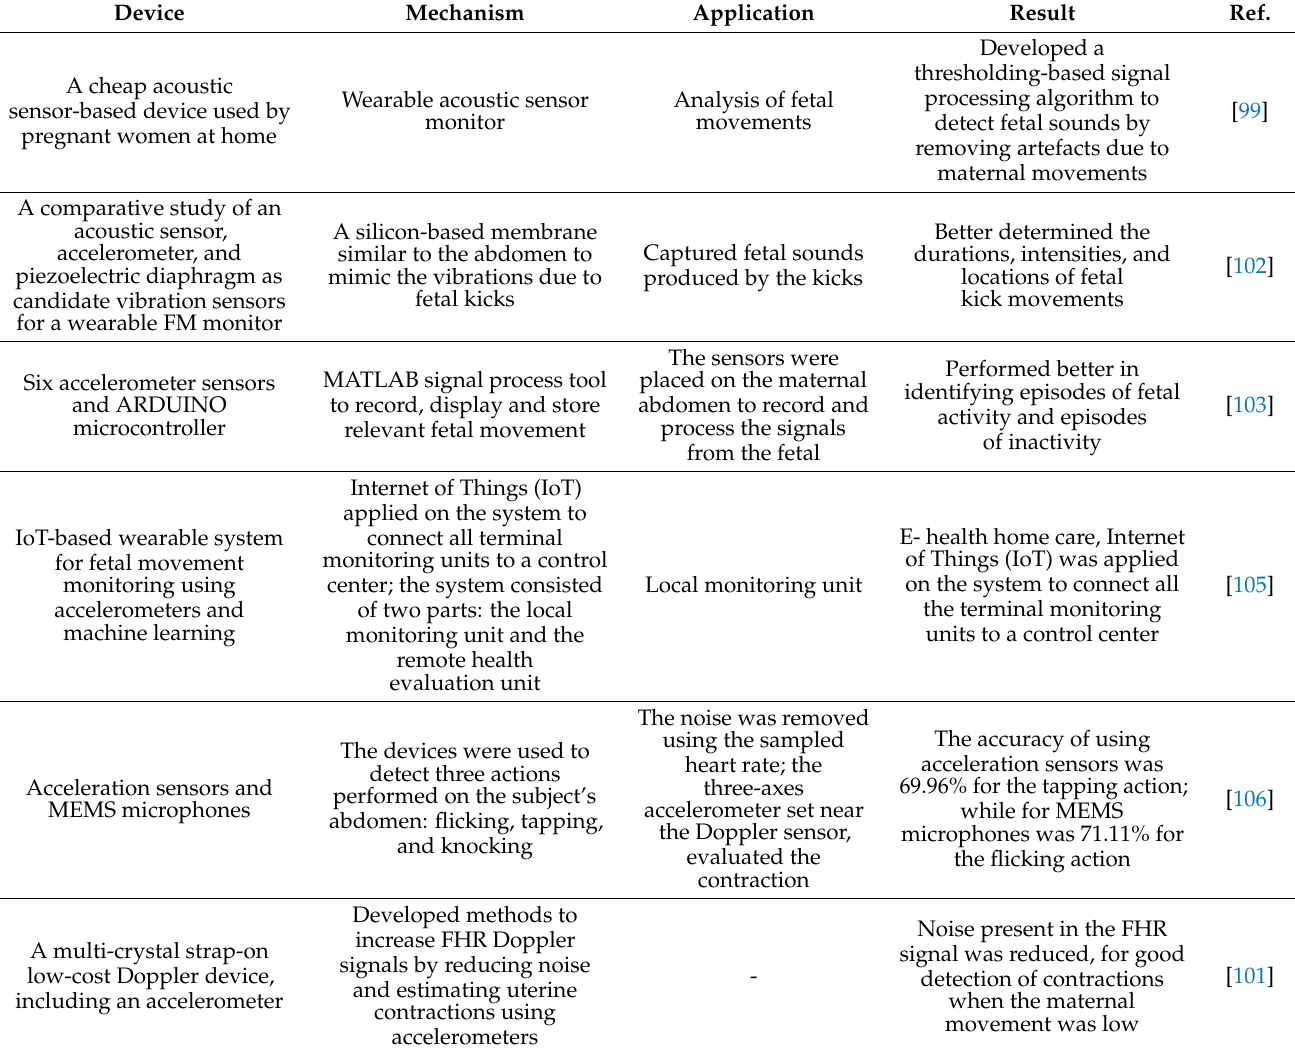
Table 3. Devices to detect fetal acoustic